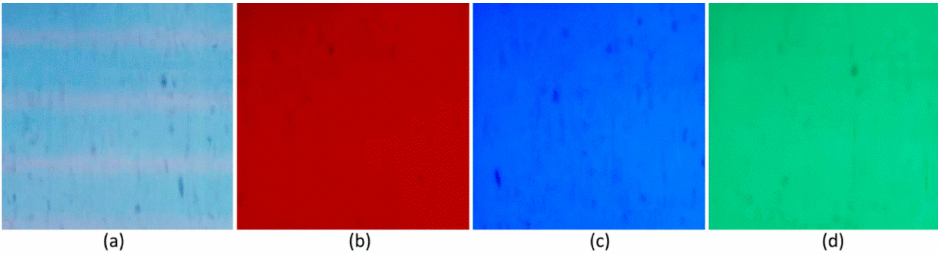
Figure 6. Recorded images of samples illuminated with a concentration of 0.1 gL − 1 of the fish feed mass in distilled water and under different lighting colors: ( a ) white light; ( b ) red; ( c ) blue; ( d ) green.